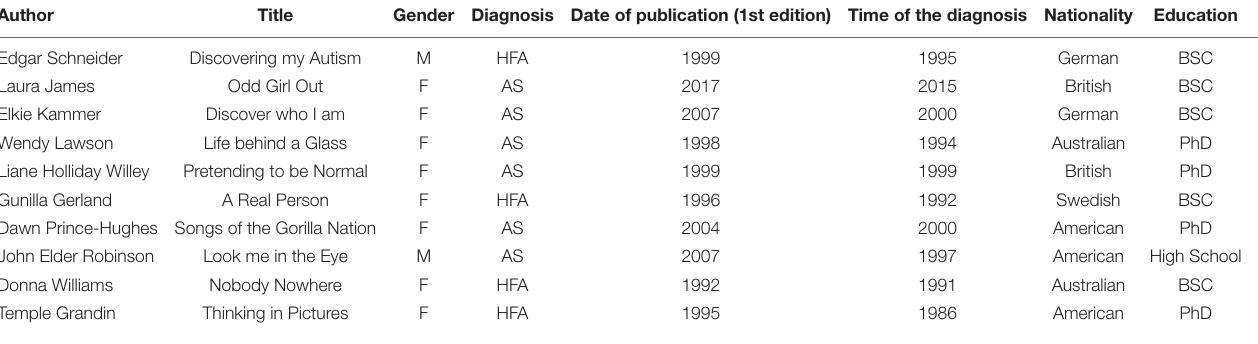
TABLE 1 | Diagnosis, time of the diagnosis, gender, nationality, and education of the authors at the time they first published their autobiographies.